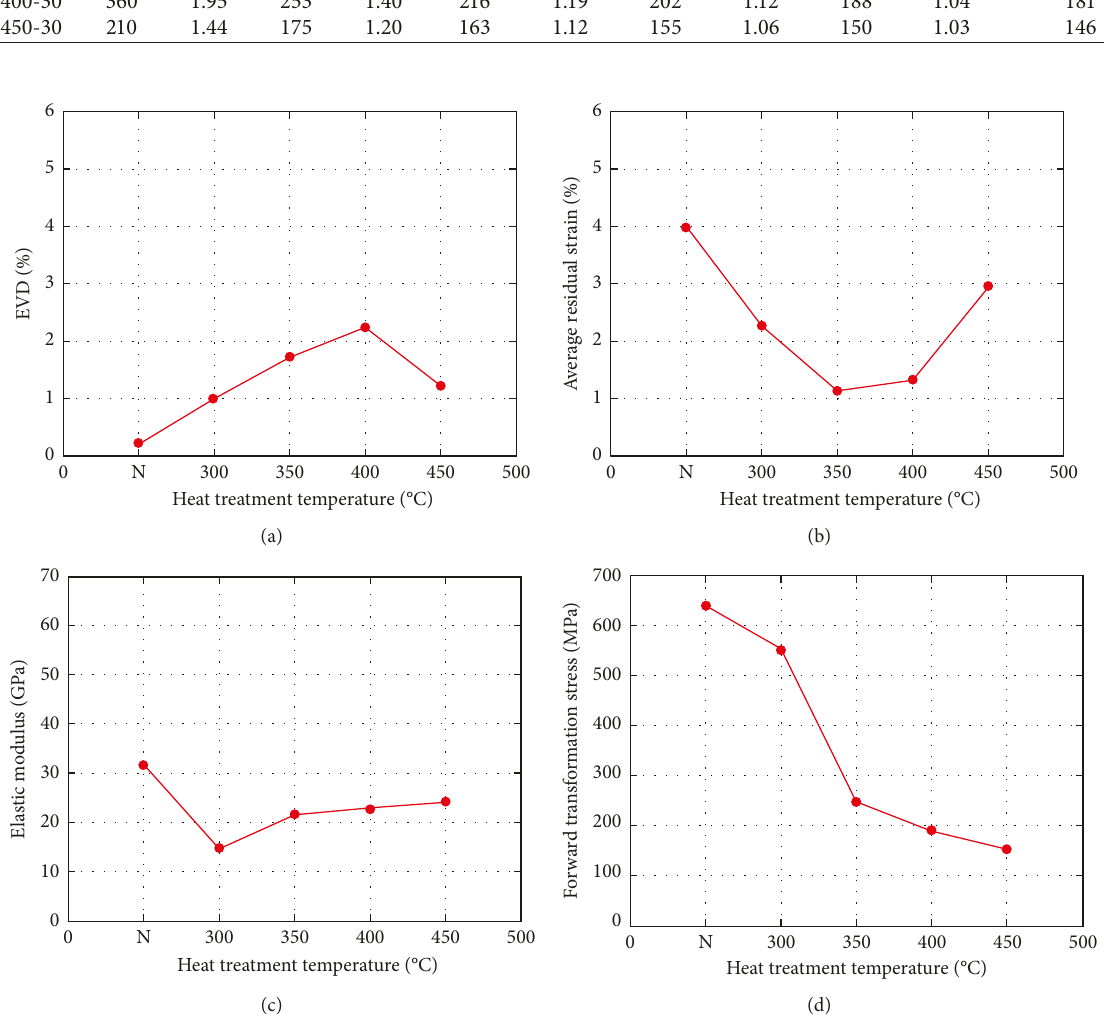
Figure 7: Effect of heat temperatures on the mechanical properties. Effect on (a) EVD, (b) average residual strain, (c) elastic modulus, and (d) forward transformation stress.